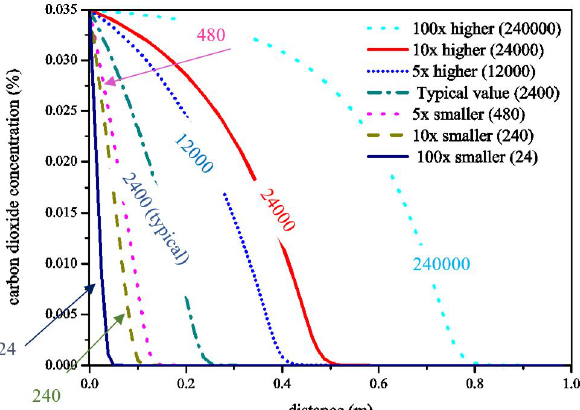
Figure 3. Parametric analyses, results for carbon dioxide field - Initial CO 2 diffusivity (values in mm 2 /day) - 50 years - Given the symmetry, in this figure only half of the profile is presented